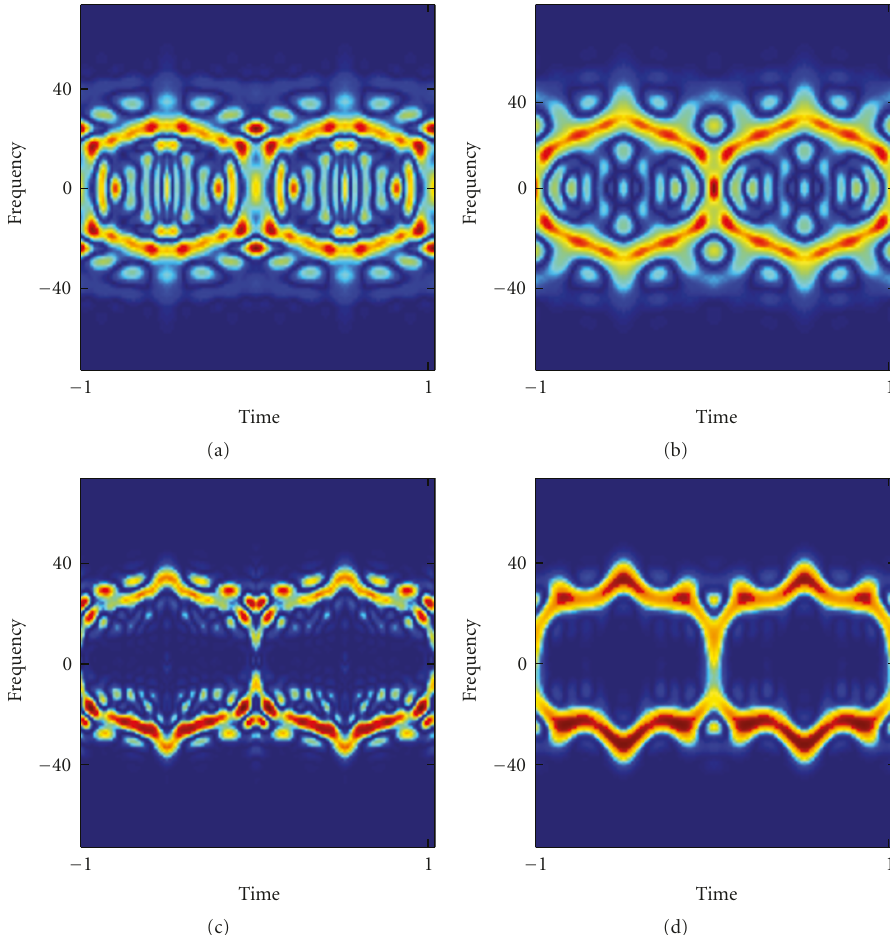
Figure 3: (a) Choi-Williams distribution; (b) GCD AF , N = 2 (smoothed pseudo-Wigner distribution); (c) GCD AF , N = 4 with Choi-Williams kernel; (d) GCD AF , N = 4 with Gaussian